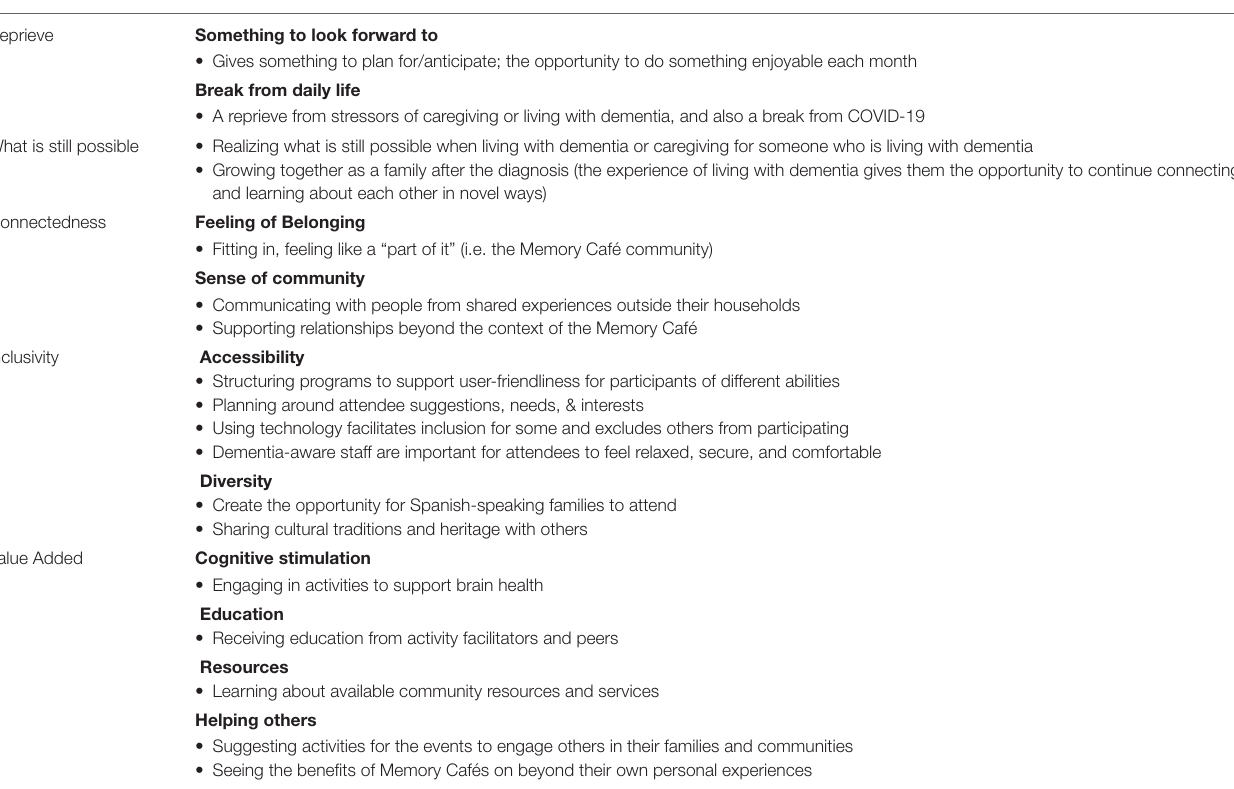
TABLE 2 | Themes, subthemes, and key findings.